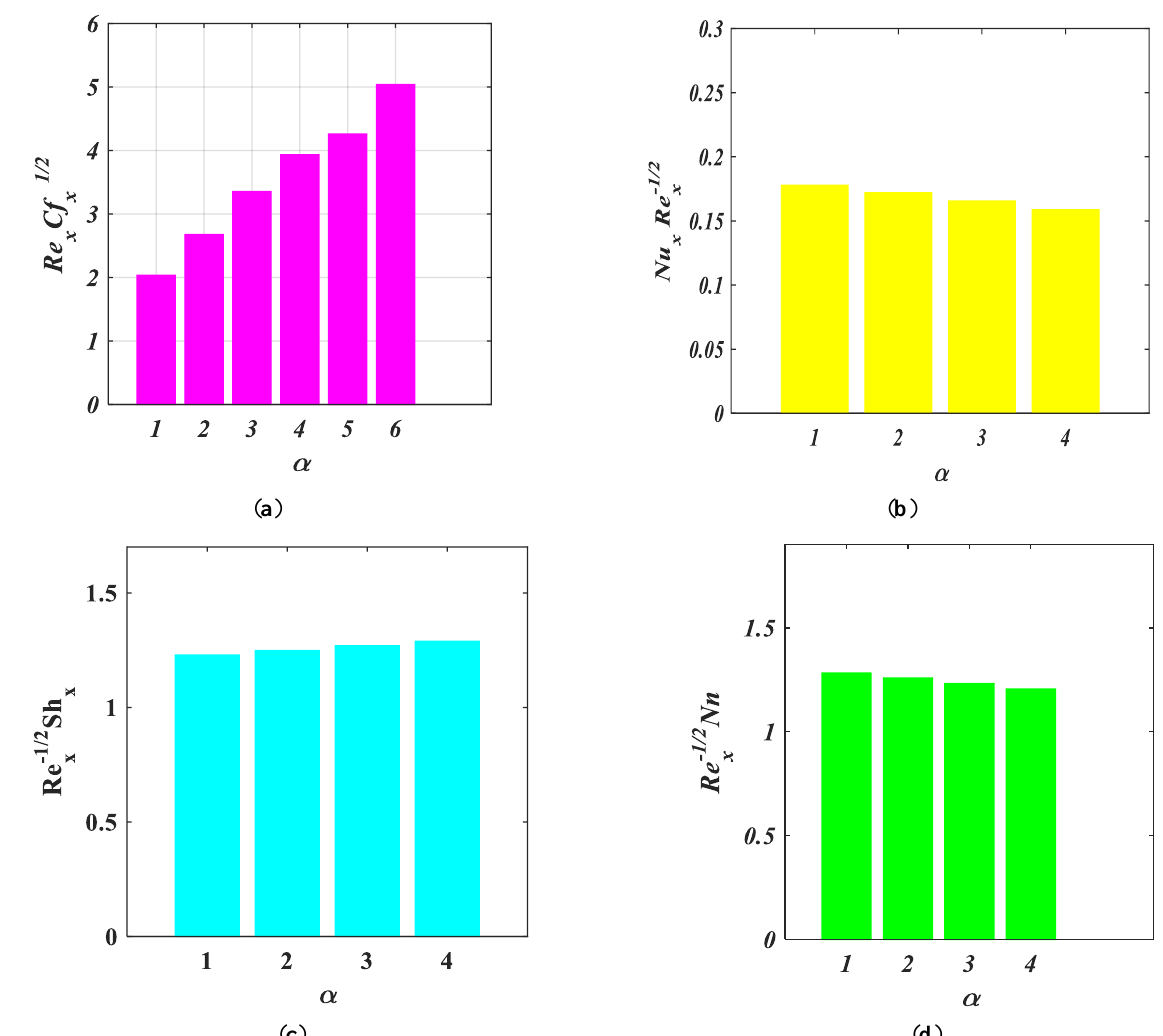
, 𝑅𝑒 𝑥−1/2 𝑁𝑢 , 𝑅𝑒 𝑥−1/2 𝑆ℎ , 𝑅𝑒 𝑥−1/2 𝑁ℎ , Re − 1/2 x 𝑥 𝑥 𝑥 against 𝑥 x